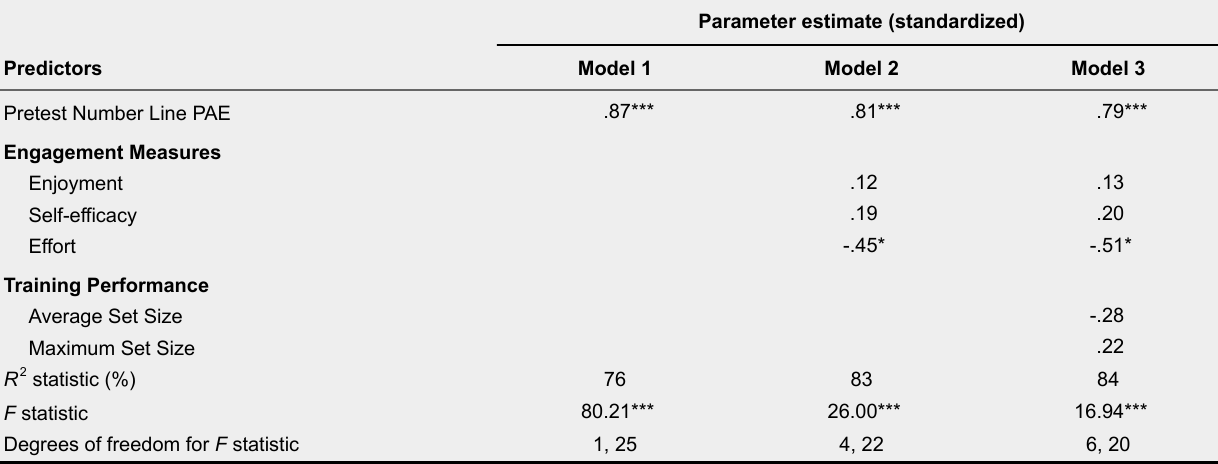
Multiple Regression Models Predicting Children’s Number Line Estimation Posttest Performance for the Working Memory Training